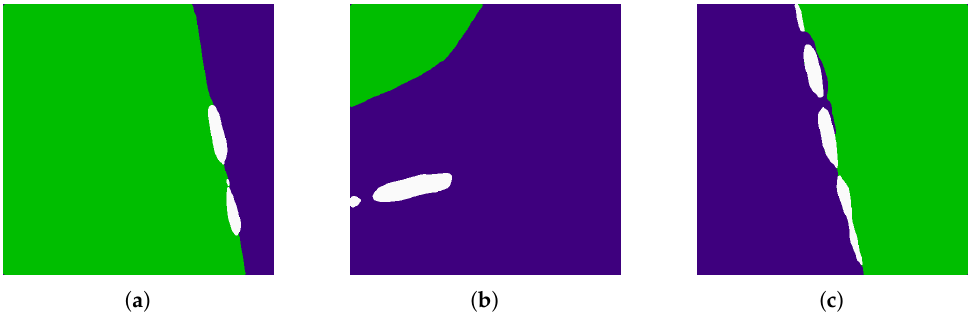
Figure 9. Zoomed in semantic labeling results ( bottom ) on GaoFen-1 images ( a - c ), presented with The original image ( top ). Here sea, land and ship are labeled as blue, green and white, respectively.